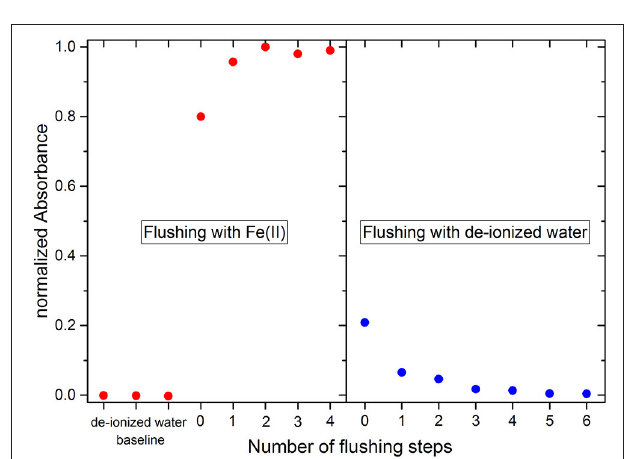
FIGURE 3 | Required flushing steps to avoid a carry-over of reagents and standards. The x-axis shows how many flushing steps with a pump stroke duration of 6s have been applied prior to the injection of the reagents with a pump stroke duration of 24s for the final absorption measurements. Red data points indicate flushing and absorption measurements with a 1 µ M Fe(II) standard, whereas blue data points represent de-ionized water. The first three data points refer to de-ionized water measurements and were set as 0. The maximum absorbance for the Fe(II) standard was normalized to